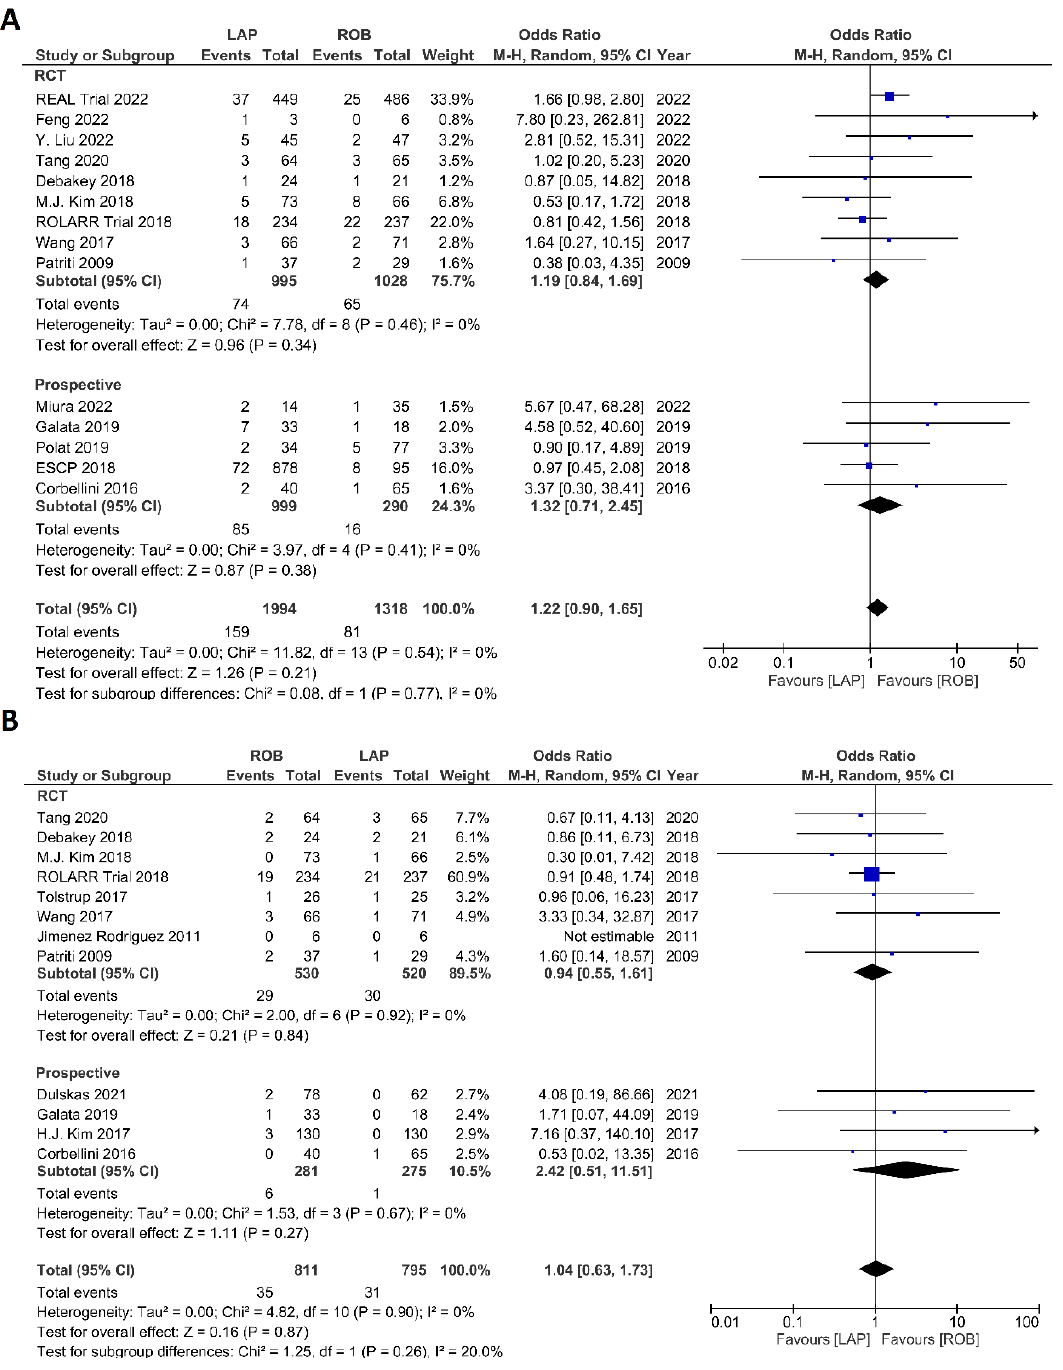
Figure 8. Forest plots comparing ( A ) anastomotic leakage [17 – 19,23,34,35,37,39,41 – 44,48,51,52] and ( B ) surgical site complications [54] between robotic and laparoscopic rectal resection (blue boxes representing odd ratios, arrows representing 95% confidence intervals, and diamonds representing point estimates of pooled odd ratios or mean differences).